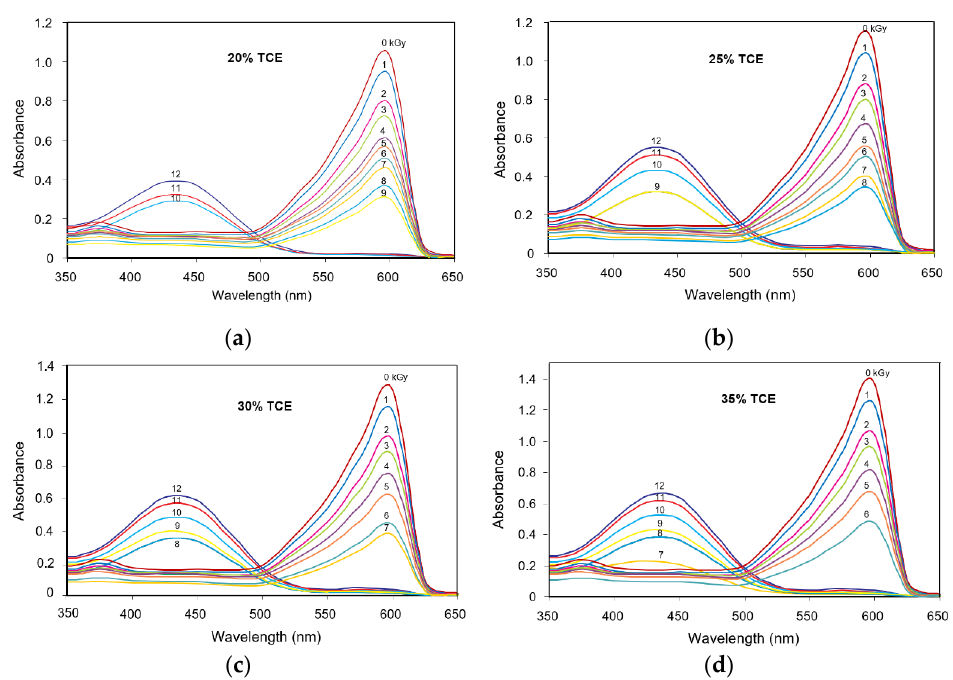
Figure 2. Absorbance spectra of CR dyed PVA-TCE composites containing; ( a ) 20%; ( b ) 25%; ( c ) 30%; and ( d ) 35% TCE irradiated with γ -rays at various doses.